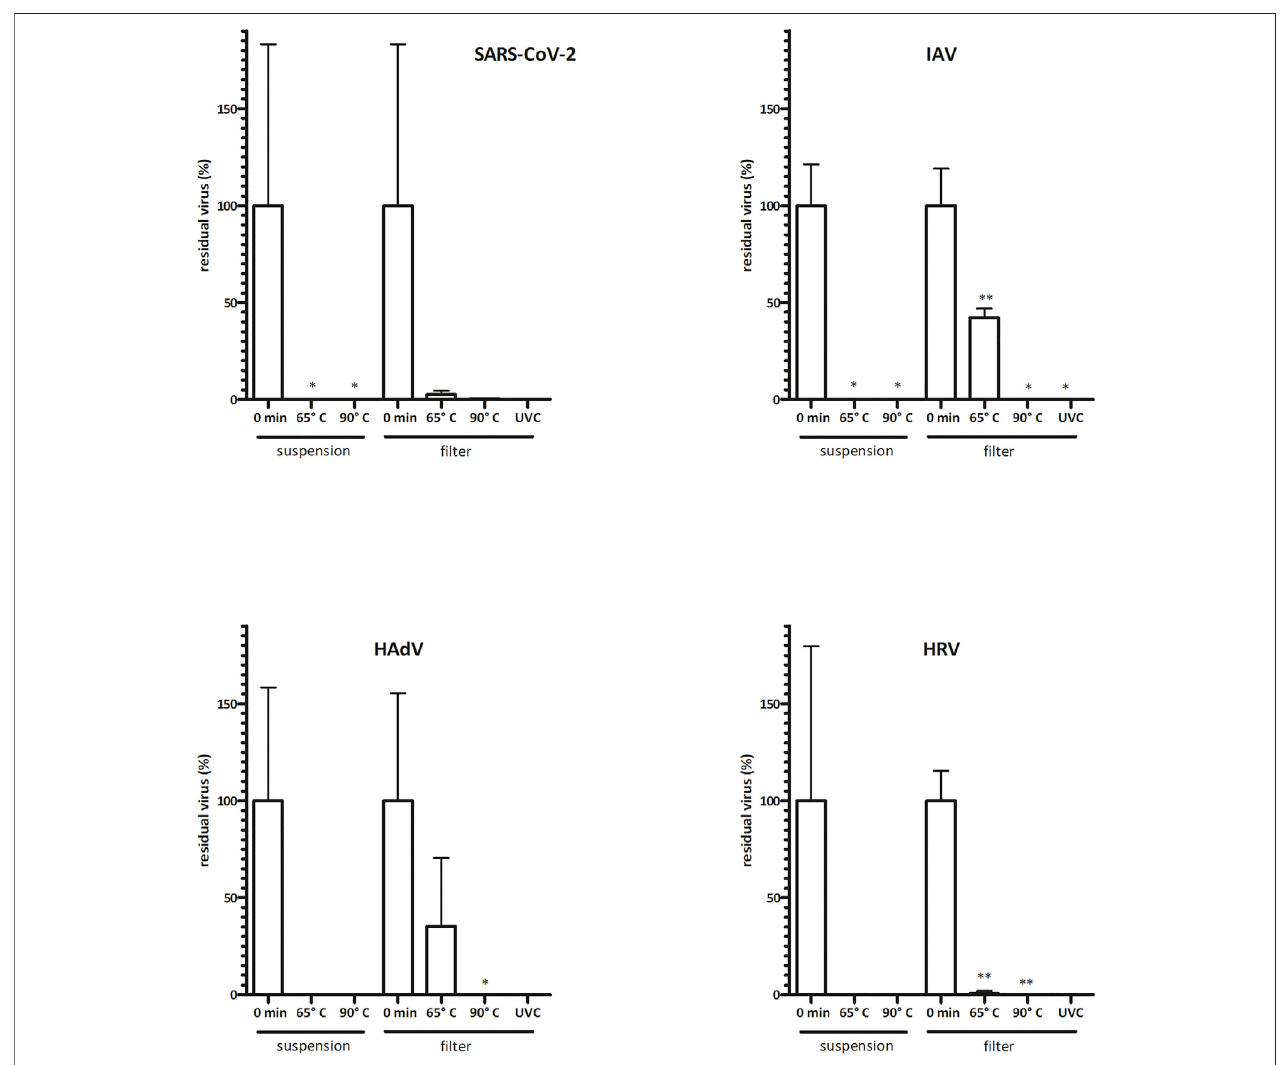
FIGURE 2 | Virus infectivity is abolished upon commonly used disinfection methods. Virus inoculum (20 μ L, 10 6 IU/ml) was applied onto P3 R fi lters or was kept in suspension and exposed to dry heat (15 min) or UVC (30 min). Residual viruses were collected by washing with PBS, and titers were determined by TCID50 or IF assay (infectious titer). Data are plotted as % of untreated control samples (virus applied onto fi lters and kept in a laminar fl ow box for the respective times indicated on the abscissa);themeanofthreebiologicalreplicates ±SEMisshown; t -test statisticalanalysis:*= p < 0.05, **= p < 0.005.Absolutevaluesofvirustiterareindicatedin Supplementary Table S1. Virus infectivity was only reduced upon thermal treatment at 65 ° C, revealing greater stability of virus particles treated on fi lters than those in suspension. Infectivity was completely abolished upon thermal treatment at 90 ° C or exposure to UVC. Fluctuations in test results re fl ect the complexity of the biological system. HAdV = human adenovirus, HRV = human Rhinovirus, IAV = In fl uenza A, SARS-CoV-2 = severe acute respiratory syndrome coronavirus 2, SEM = standard error of the